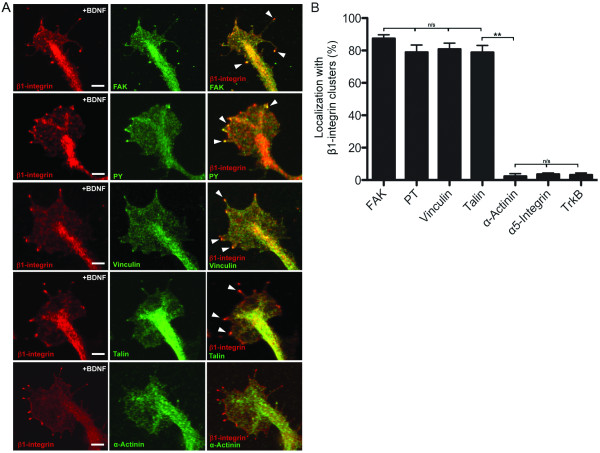
BDNF triggers the formation of nascent growth cone adhesions. (A) Representative confocal images of dual immunolabeled growth cones showing β1-integrin (red) and known cytoplasmic adhesion components (green: FAK; PY; vinculin; talin; α-actinin) after BDNF treatment (50 ng/mL; 20 min). Arrowheads in the merged images denote spots of co-localization. Scale bar, 5 μm. (B) Quantification of the percentage of total immunostaining for adhesion components, α5-integrin, and TrkB receptors that overlapped with β1-integrin clusters. Data are the mean ± standard error of the mean. (n > 40, n/s P > 0.05, **P < 0.001, ANOVA with Tukey's post hoc analysis.) BDNF: brain-derived neurotrophic factor; FAK: focal adhesion kinase; PY: phosphotyrosine.